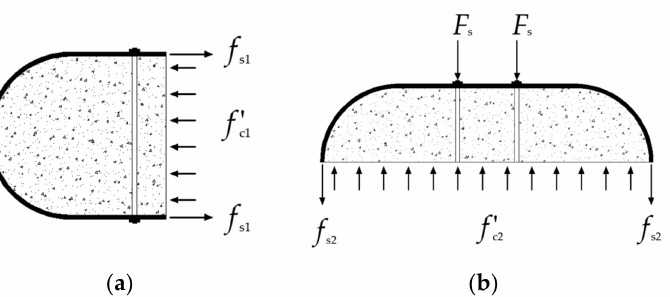
Figure 16. Interactions between the various components of the RRCFST with tie bars: ( a ) Round- ended part; ( b ) Rectangle